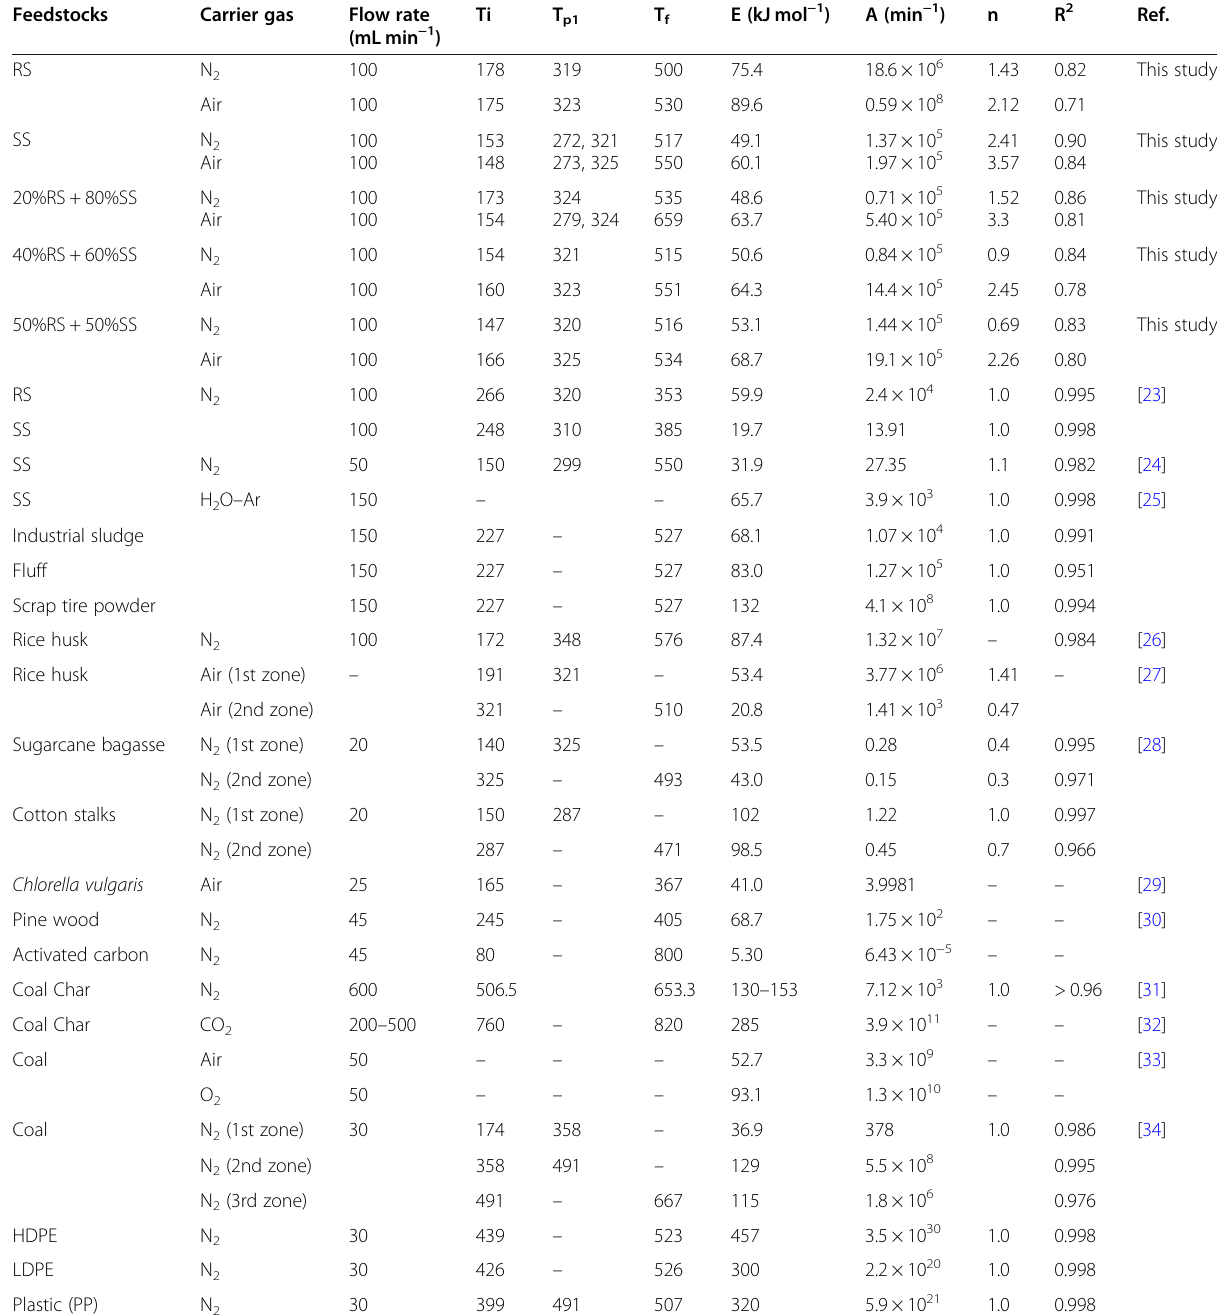
Table 2 Comparison of the kinetic analysis in this study and those in the literature